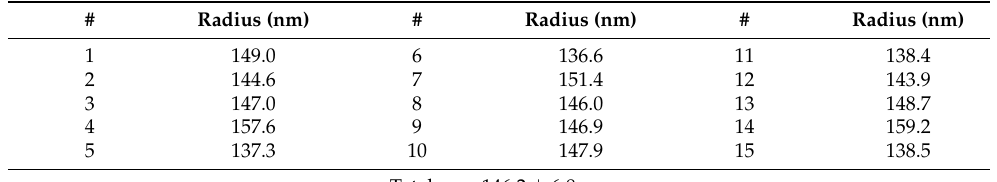
Figure A1. SEM micrograph of the dust particles collected after a growth period of T = 60s. The individual particles are marked with a red circle and labeled. The scale bar on the bottom right indicates a size of 4 µm. The data in this figure has been published in Tim Jacobus Adrianus Staps et al. [31] 2022 J. Phys. D: Appl. Phys. 55 08LT01 (https://doi.org/10.1088/1361-6463/ac3581), licensed under a Creative Commons Attribution (CC BY) license and used with the permission of the authors. Table A1. Calculated radii of the collected dust particles. The labels in this table coincide with the labels in Figure A1. From these 15 particles, the mean size and its standard deviation are